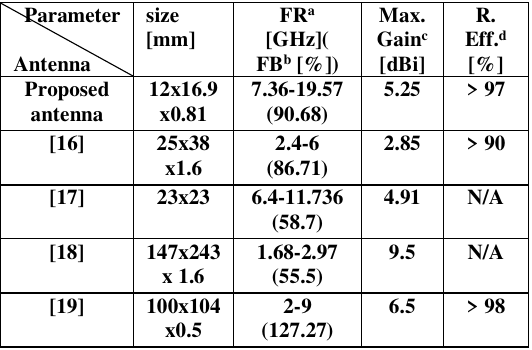
Table 2. Comparison between previously published UWB antennas and the proposed